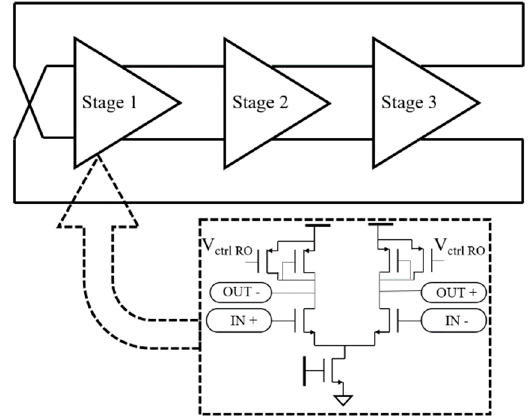
Figure 5. Ring oscillator schematic.